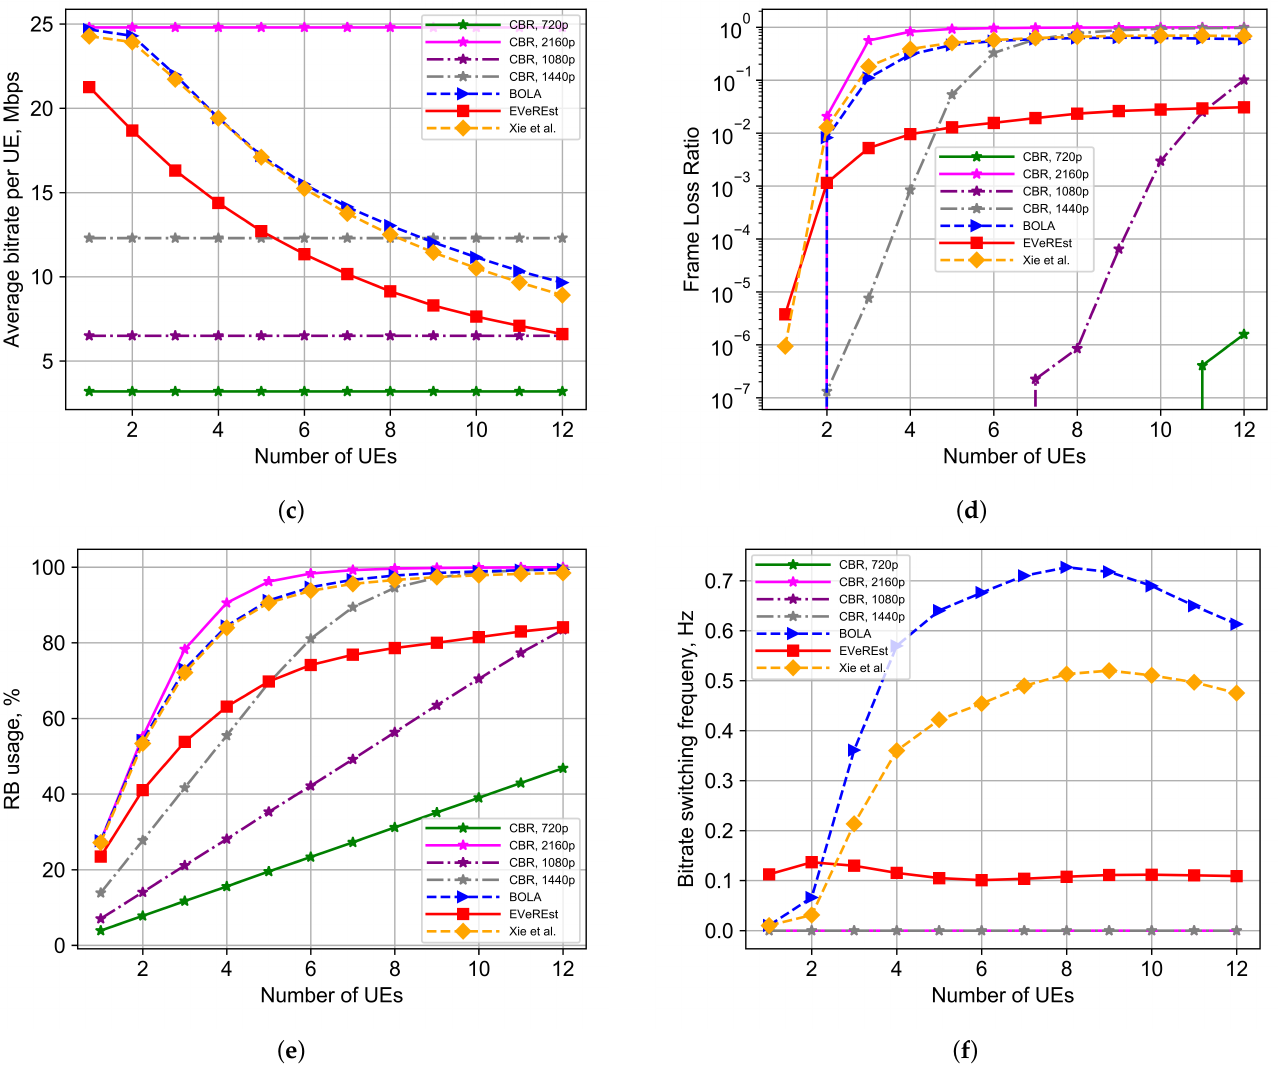
Figure 2. Comparison of the QoE provided by the algorithms. ( a ) The number of satisfied VR sessions. ( b ) The goodput of the system. ( c ) The average bitrate of cloud VR sessions. ( d ) The average frame loss ratio. ( e ) The average share of utilized resource blocks. ( f ) The average bitrate switching